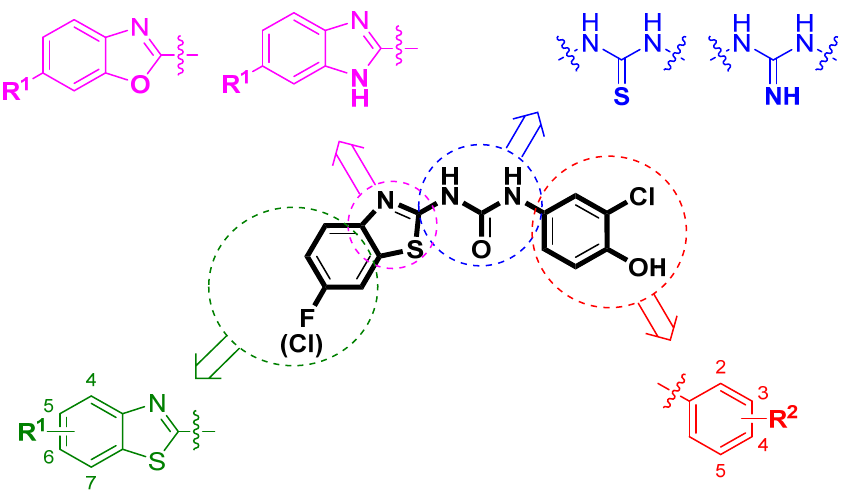
Figure 2. Design of novel 17 β -HSD10 inhibitors. The original scaffold was divided into for parts (depicted in violet, blue, green, and red) and each part was modified separately.